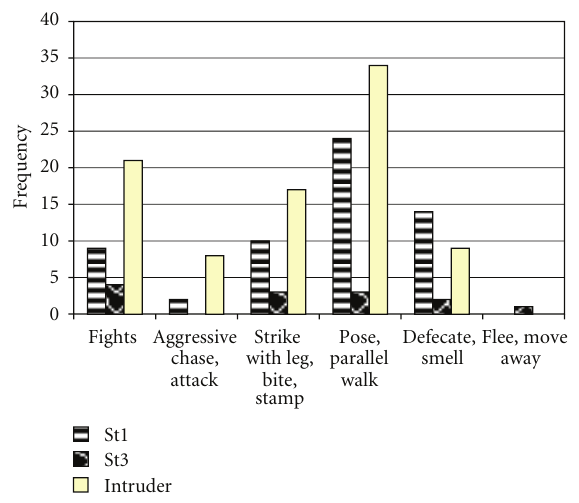
Figure 5: Frequencies of di ff erent behavioural acts between St2 and three stallions (his neighbours and the